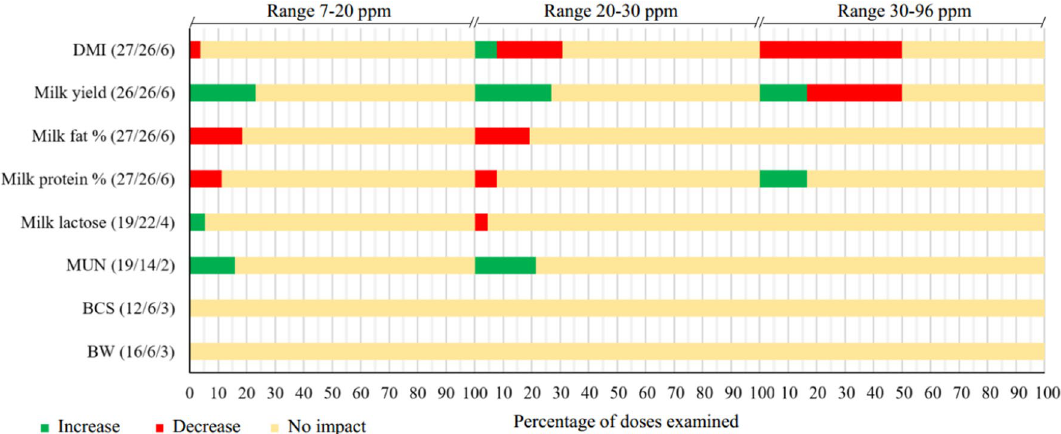
Figure 2. Percent effectiveness of "examined monensin doses" on outcomes in dairy cows. The effect was considered significant if the overall P value of the model was less than 0.05. Numbers in parentheses preceding results indicate the number of studies that examined the above dose ranges, separated by the slash